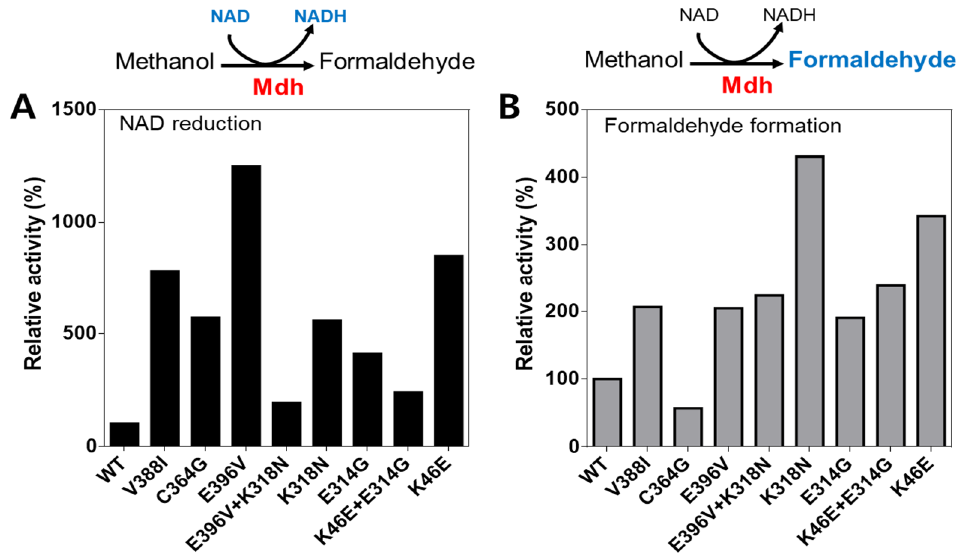
Figure 4. Comparison of enzyme activity between the wild-type (WT) and its mutants by the NAD reduction rate ( A ) and the concentration of formaldehyde generated from methanol by enzymes ( B ). The reaction mixture included 0.05 mg/mL protein, 10 mM NAD + , 5 mM Mg 2+ , and 100 mM methanol in 50 mM CHES (pH 9). The NAD reduction rates were monitored at RT (room temperature) for a short time (60 s) by spectrometer. For detection of the released formaldehyde concentration, samples were incubated at 55 °C for 10 min, and subjected to HPLC as described in the text.